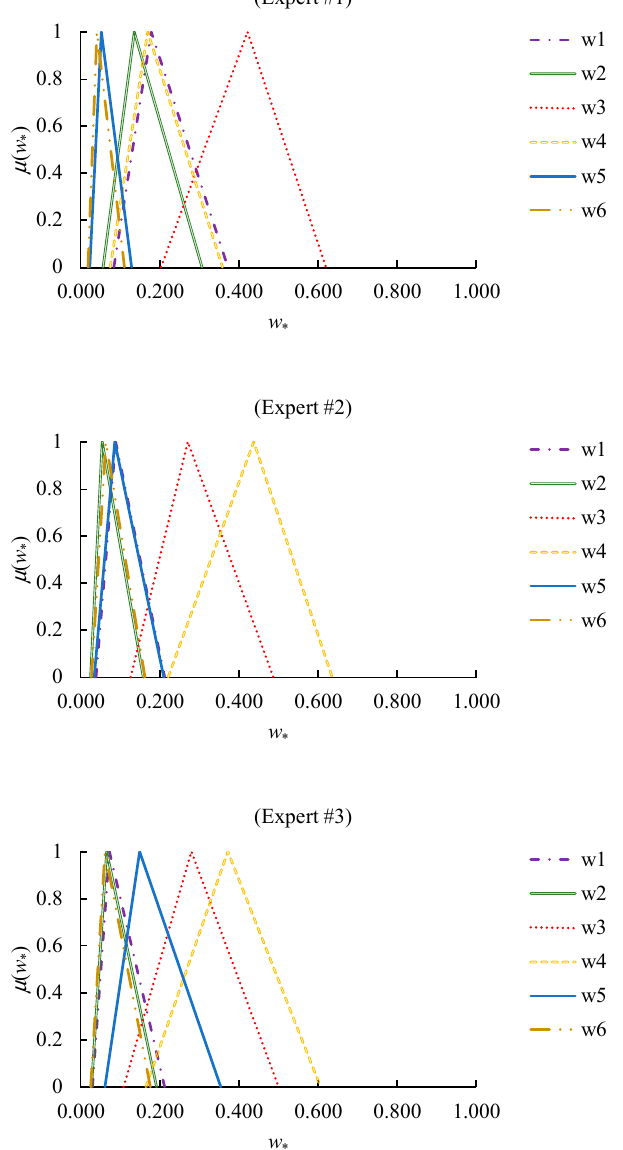
Figure 9. The relative priorities of factors evaluated by experts.